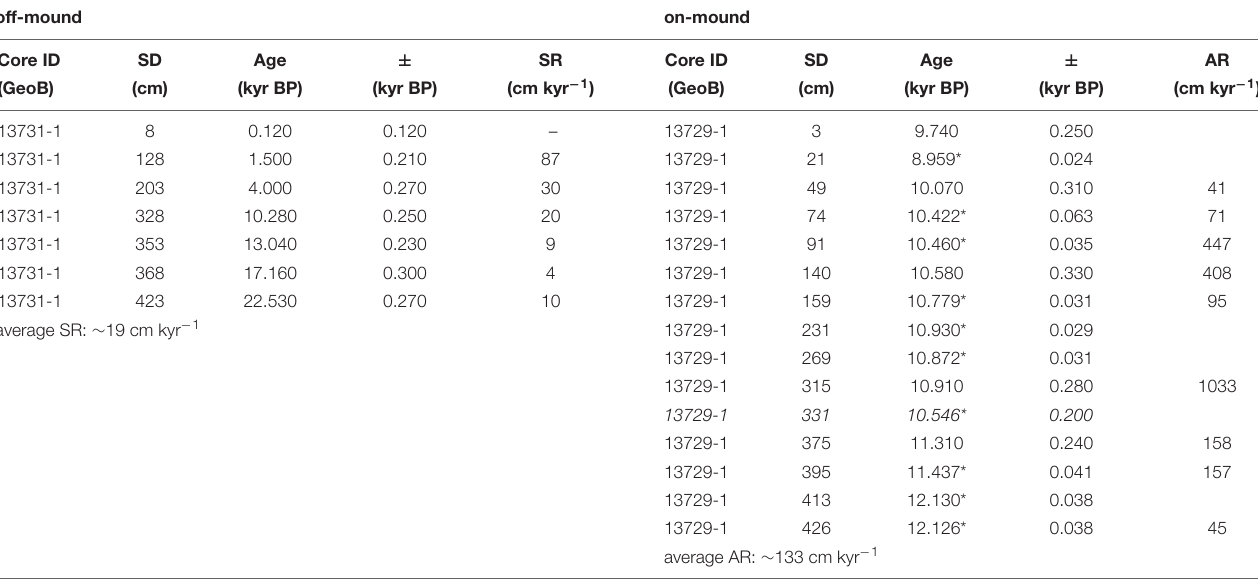
TABLE 3 | Sedimentation rates (SR) calculated for off-mound core GeoB13731-1 and mound aggradation rate (AR) calculated for on-mound core GeoB13729-1 (U/Th dates are marked by an asterisk; note that one coral age at 331 cm core depth ( ∼ 10.5 kyr BP; given in italic) was disregarded for AR calculation). SD, sampling depth. For further explanation see